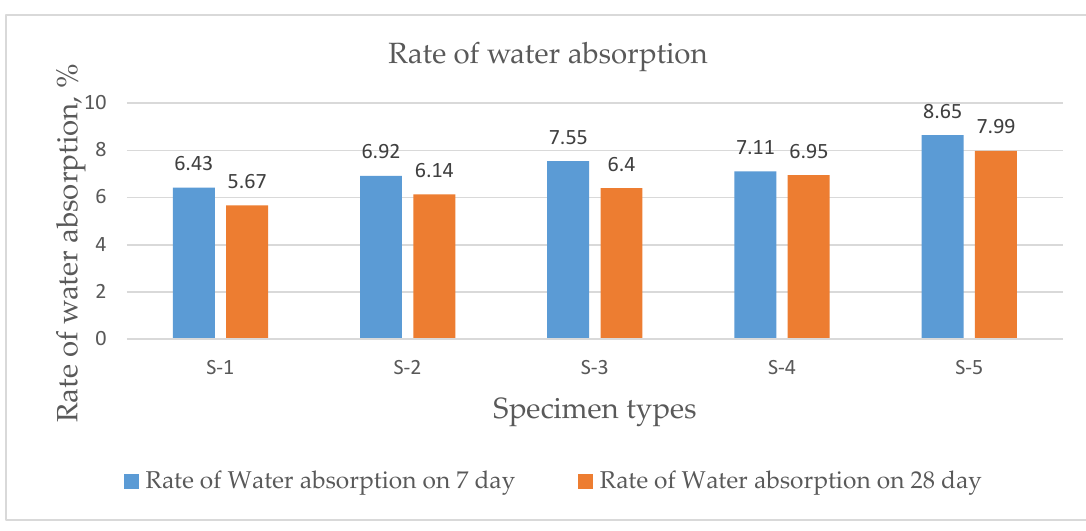
Figure 3. Water absorption of concrete samples on 7 and 28 day.